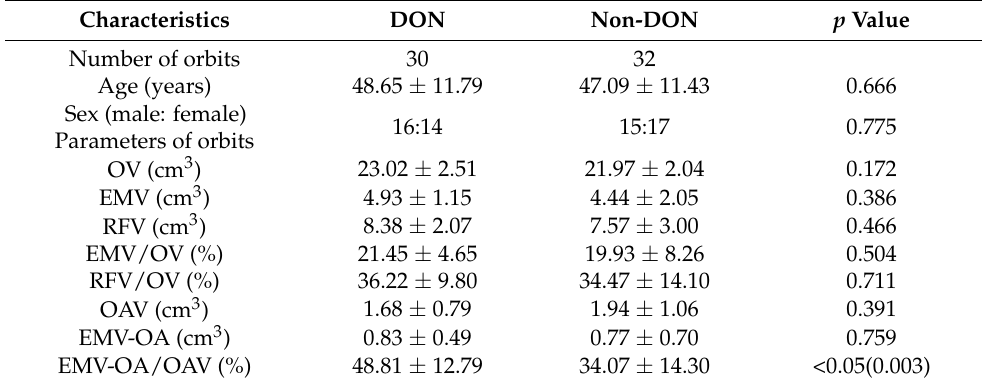
Table 2. Clinical characteristics of DON and non-DON